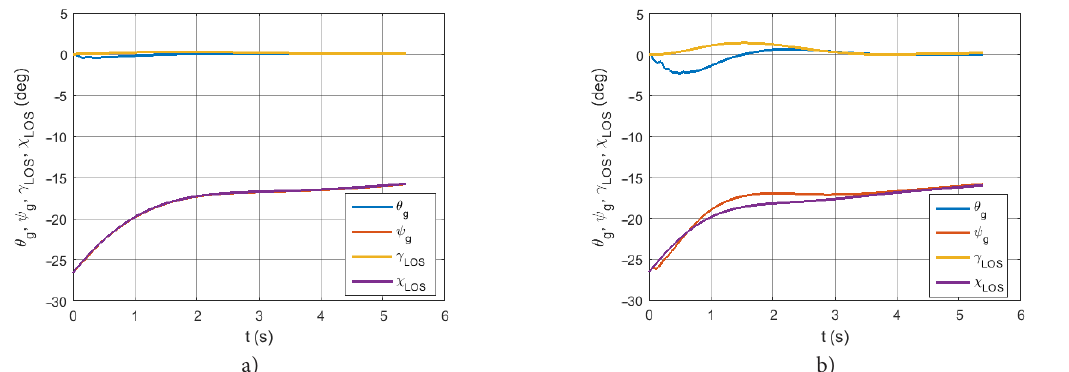
Figure 7. Pitch and yaw angles for LOS and gyroscope system axis over time, for: a) LQR, b) PD regulator